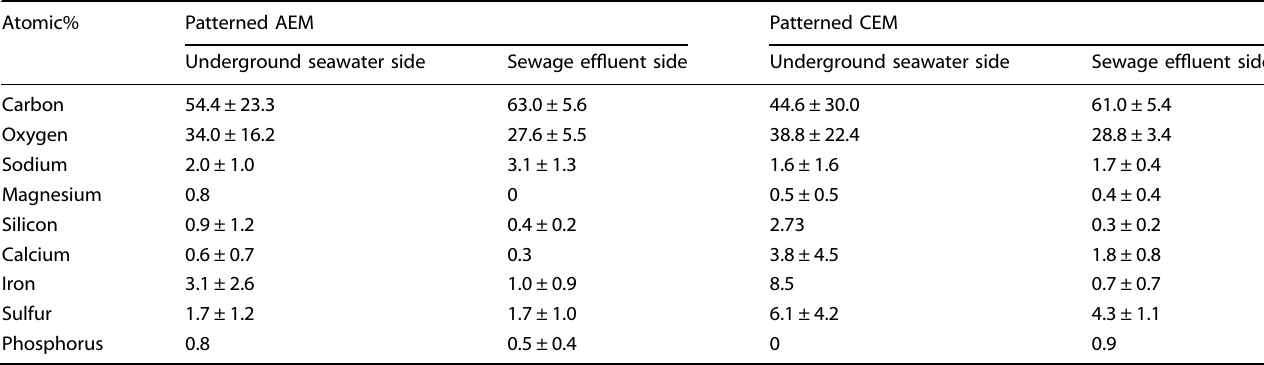
Table 2. EDX results of the AEMs and CEMs of the patterned stack after continuous reverse electrodialysis operation for 5 days. The values with standard deviations were measured from three data points and the others correspond to a single data